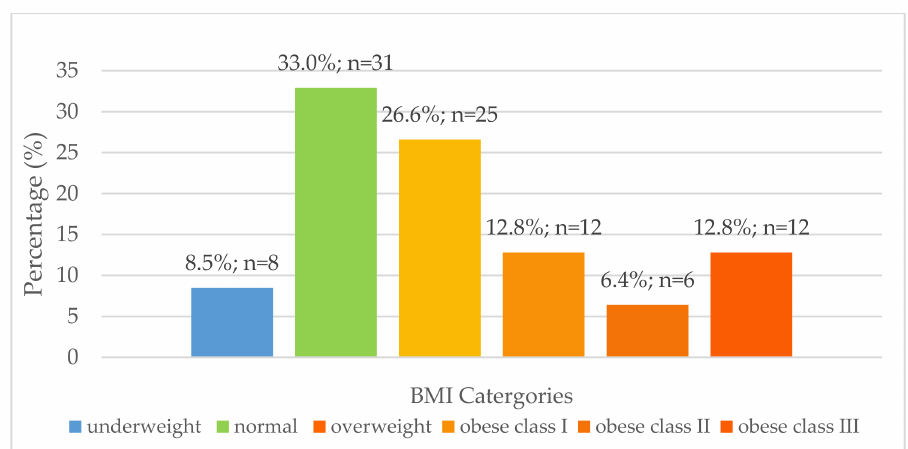
Figure 1. Distribution of body mass index for females aged 16–35 years (n =